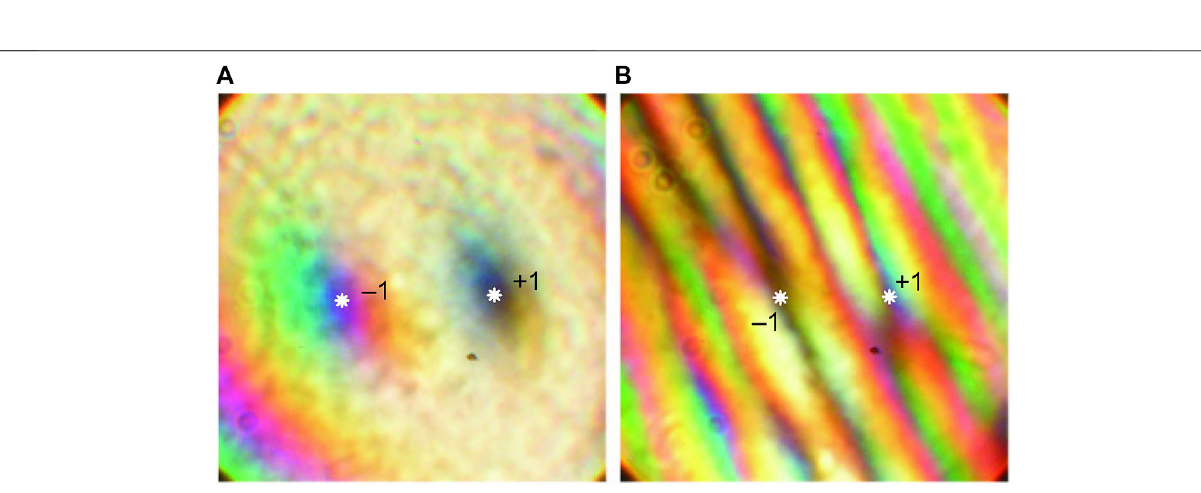
Frontiers in Physics |